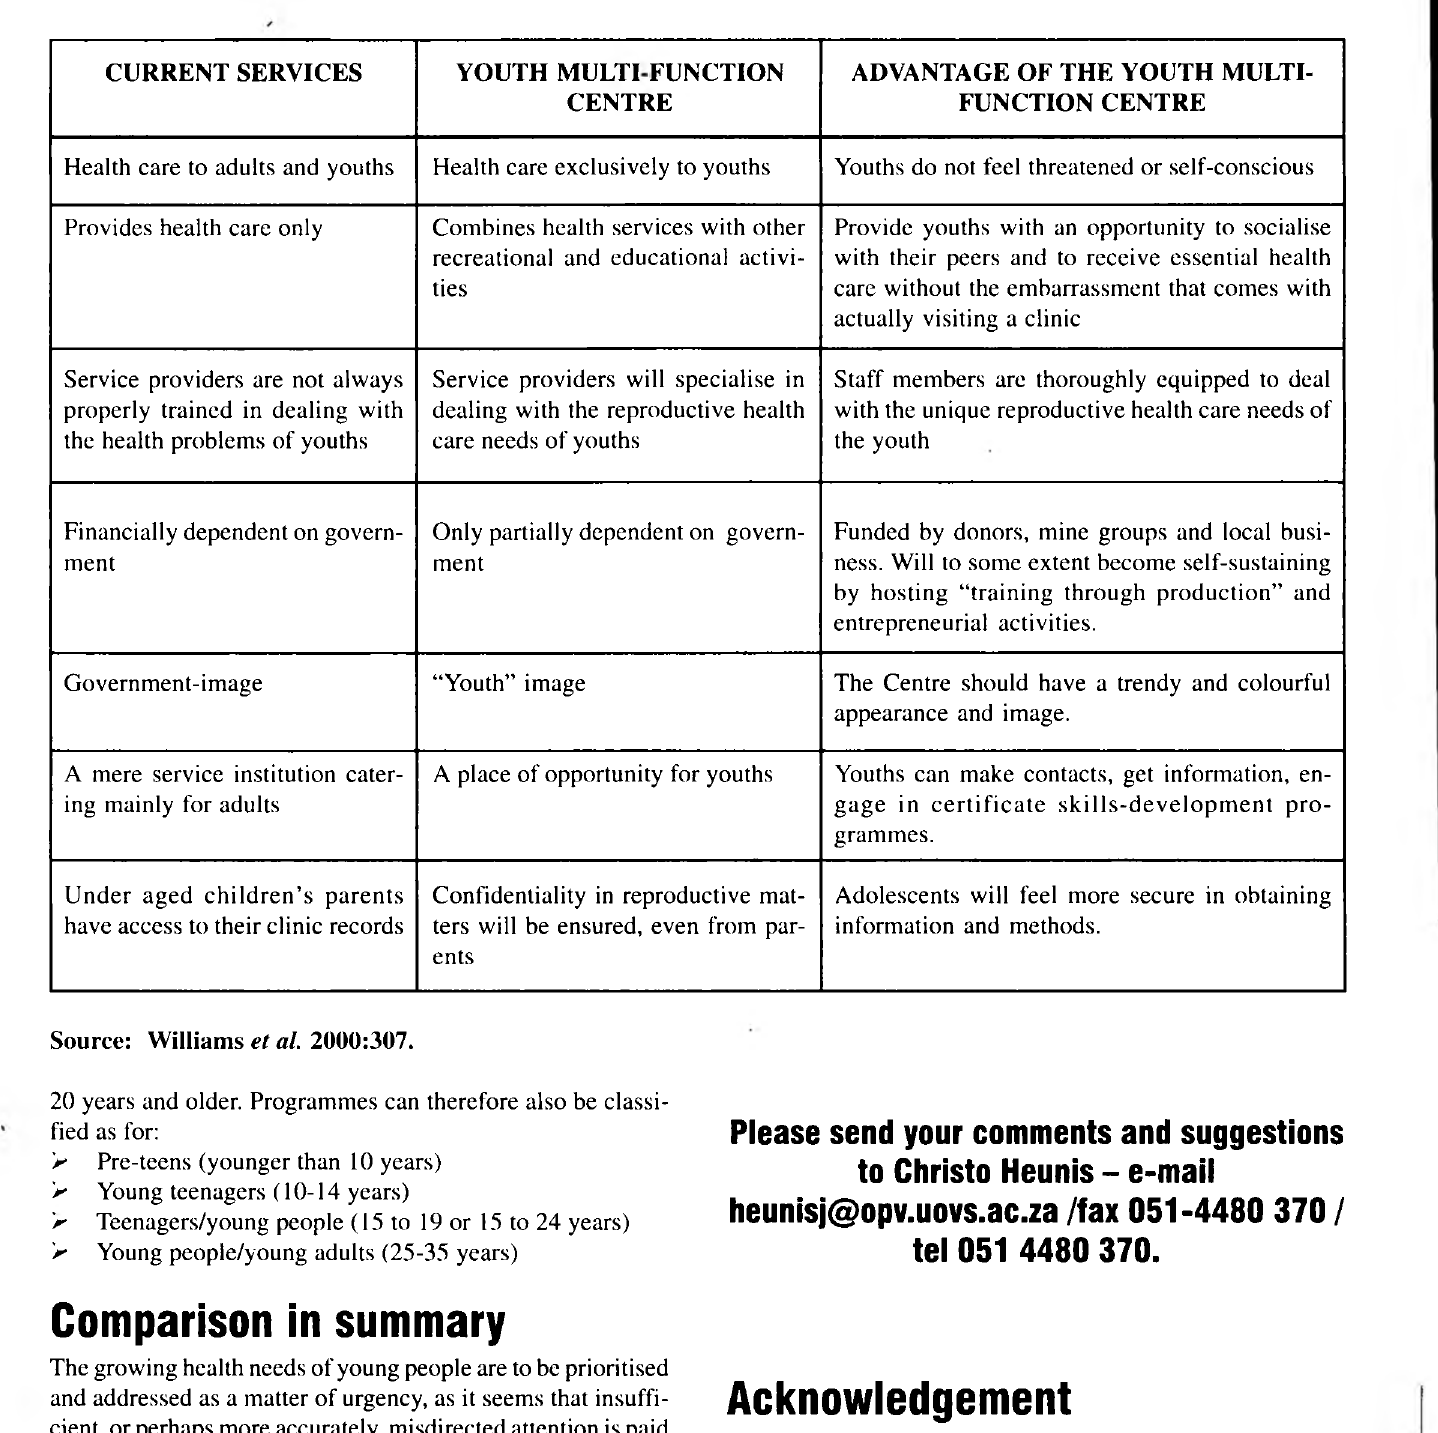
Table 1 Comparing the advantages of a Youth Multi-function Centre over current